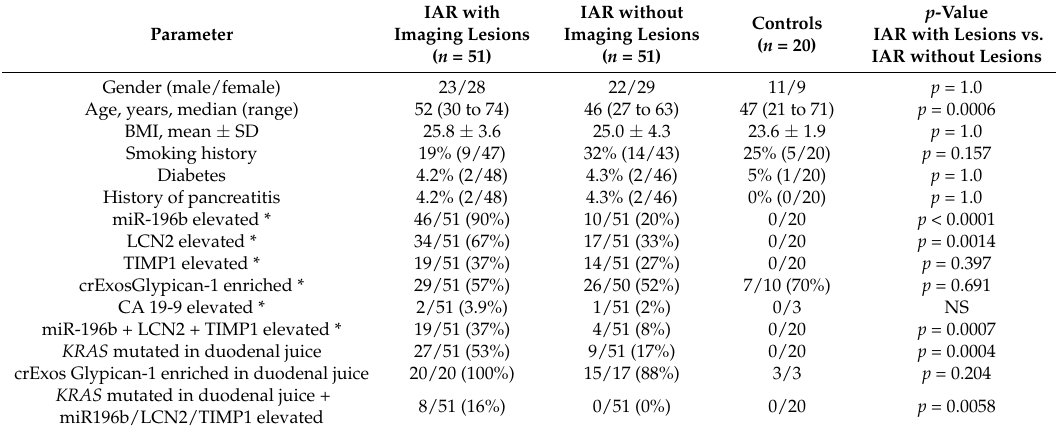
Table 6. Characteristics and biomarker analysis of IAR with or without imaging lesions who did not undergo